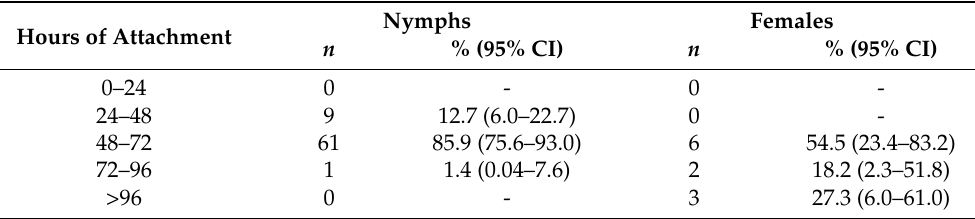
Table 1. Estimated attachment duration (in hours) of feeding I. ricinus nymphs and females removed from humans; Turin province, 2017–2020.